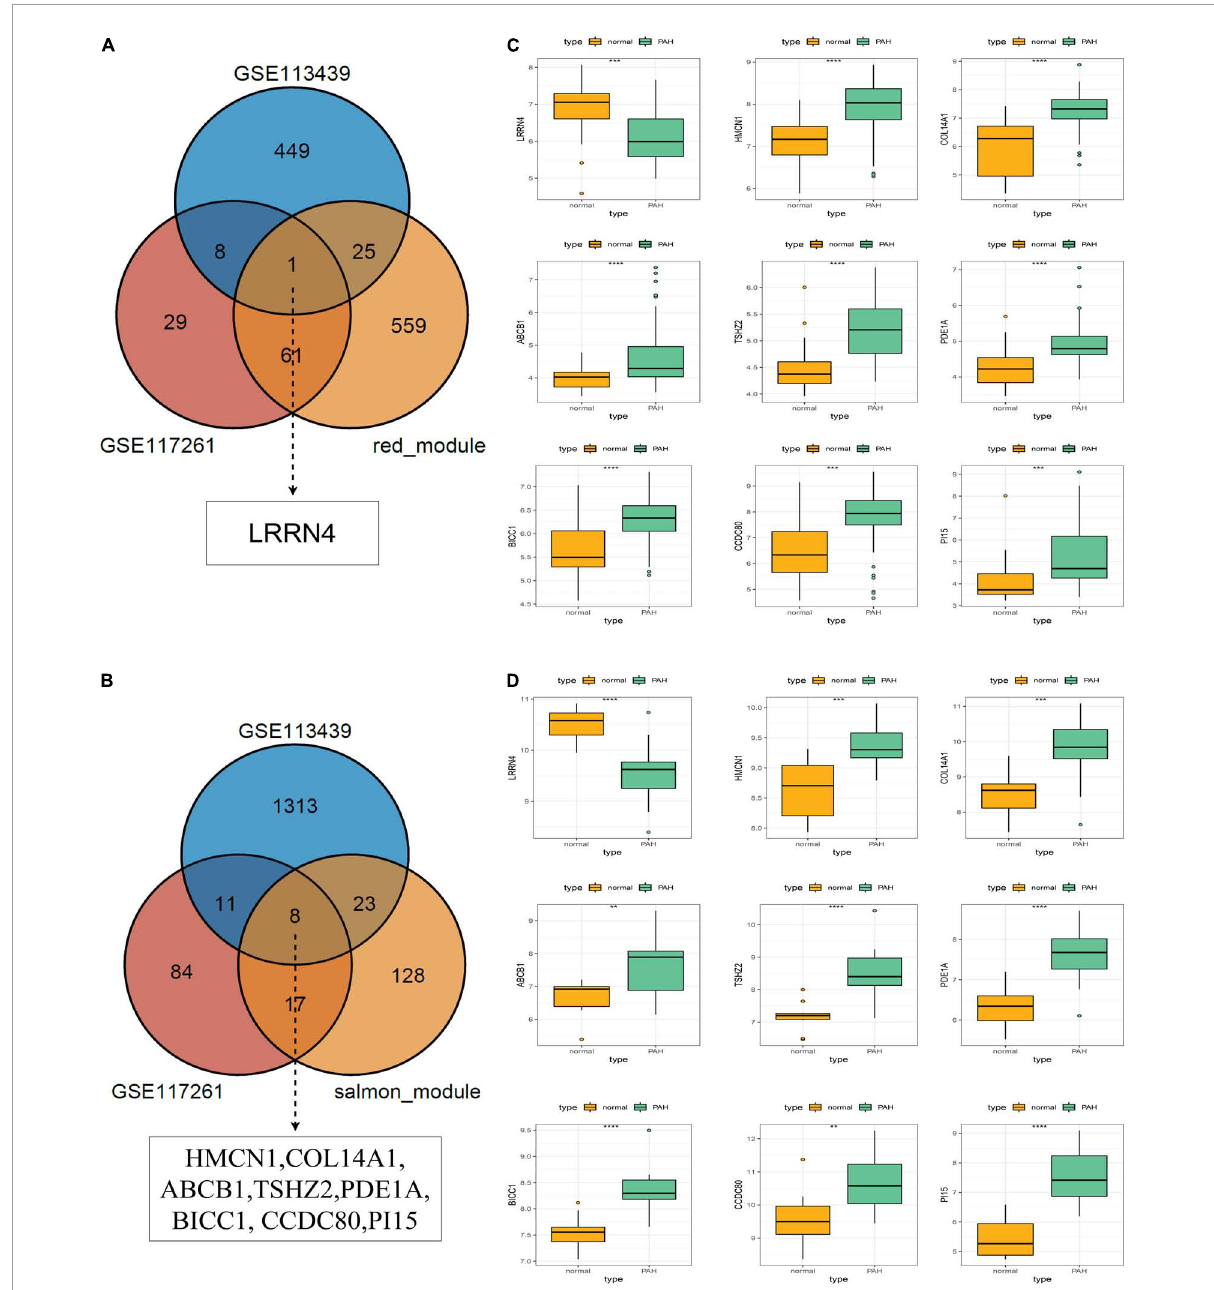
FIGURE5 Selection and validation of key regulatory genes. (A) Venn diagram to indicate one downregulatory gene from the red module and DEGs. (B) Venn diagram to indicate eight upregulatory genes from the salmon module and DEGs. (C) Validation of key regulatory genes in the dataset GSE117261. (D) Validation of key regulatory gene in the dataset